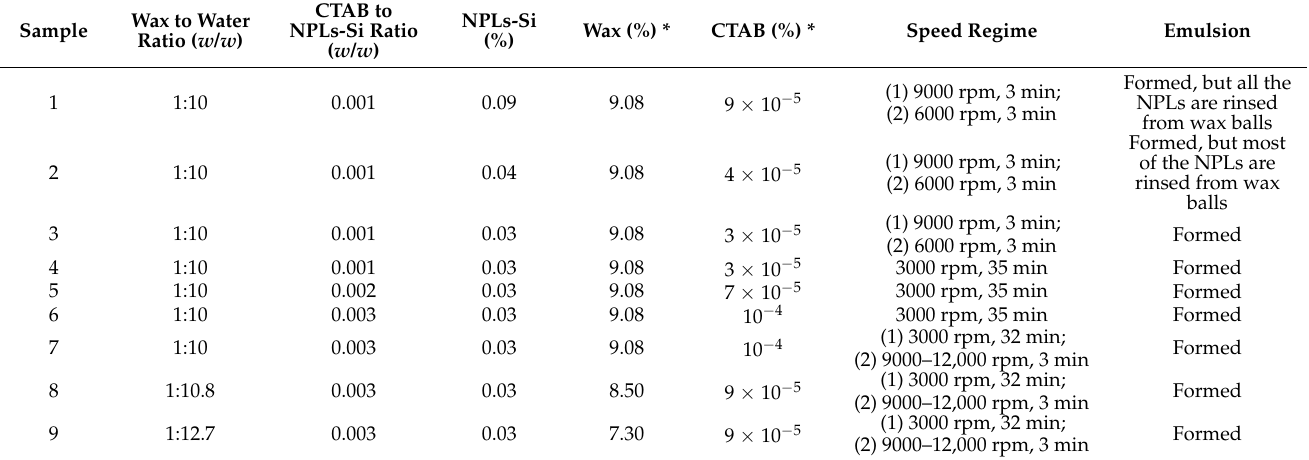
Table 2. Investigated conditions for the preparation of Pickering emulsions with